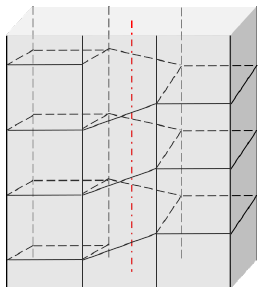
Figure 15: A cross-section of a cubic lattice with a smooth screw dislocation. The dotted red line denotes the defect line, and it cuts through the plaquettes on each plane.